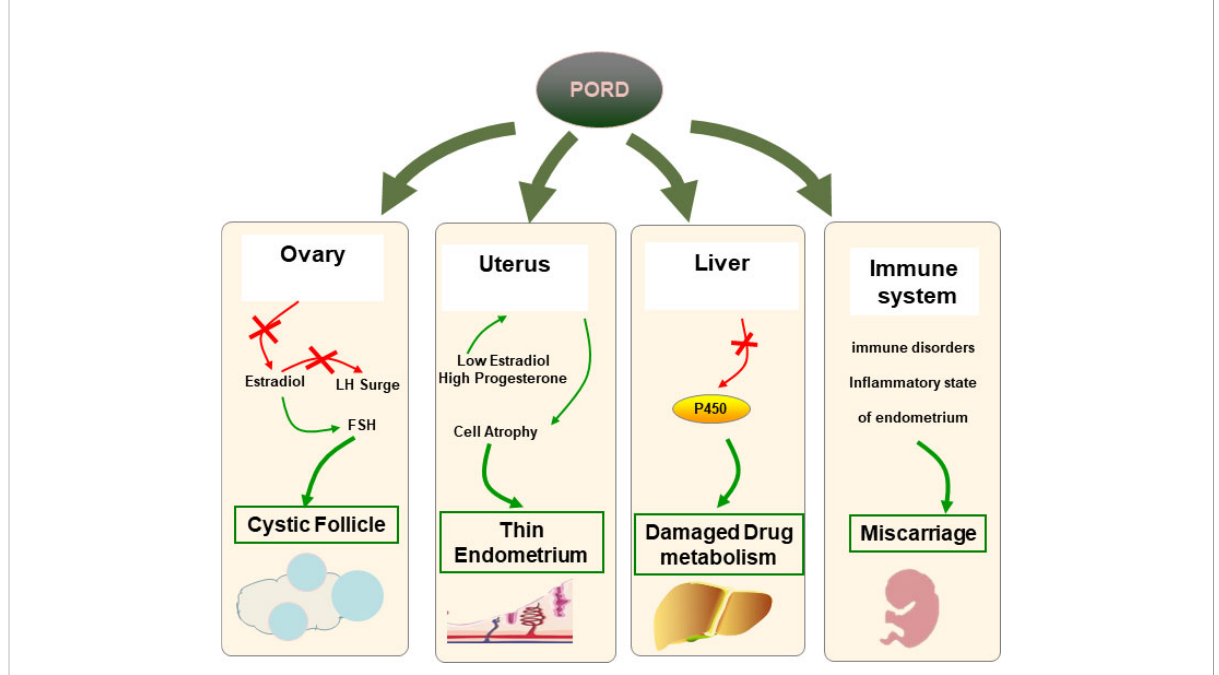
FIGURE 3 Hypothesis of associations with infertility in PORD. In ovaries, FSH fails to trigger the ovaries to produce enough E2 because of the impaired 17- a hydroxylase activities. Multiple cysts are caused by the dysfunction of the positive feedback loop to trigger the LH surge. The endometrium epithelial and stromal cells lack E2 stimulation and begin to atrophy. PORD may account for reduced hepatic drug metabolization. The risk of miscarriage may rise due to a dysfunctional endometrium and a disordered immune